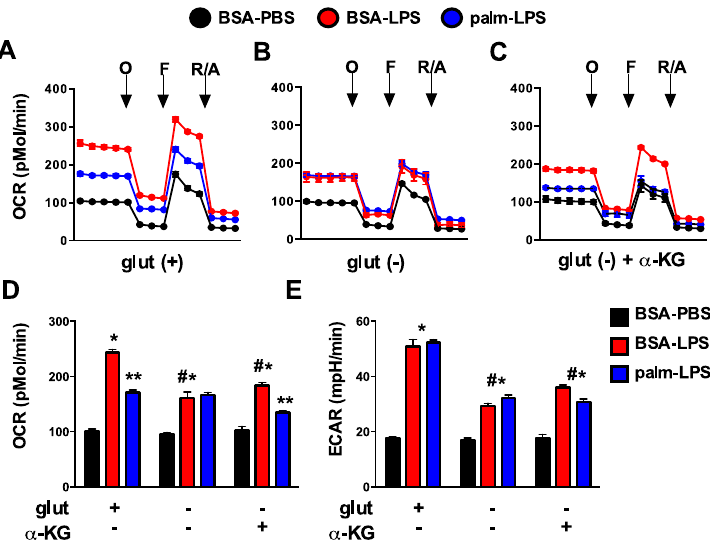
Figure 9. Glutamine deficiency alters mitochondrial metabolism. ( A – C ) pMACs were stimulated for 16 h with BSA ‐ PBS (black), BSA ‐ LPS (red), or palm ‐ LPS (blue) in glutamine sufficient media ( A ) or glutamine deficient media ± α‐ KG ( B , C ) and mitochondrial metabolism was assessed using a Seahorse flux analyzer. Mitochondrial oxygen consumption rate (OCR) was assessed at baseline and after the injection of oligomycin ( O ), FCCF ( F ) and rotenone/antamycin (R/A); ( D , E ) Baesline OCR ( D ) or extracellular acidification rate (ECAR; ( E )) are reported from cells stimulated as in ( A – C ). Bar graphs report the mean ± SE for a minimum of 3 experiments, each performed in triplicate. *, p < 0.05 for BSA ‐ PBS vs . BSA ‐ LPS; **, p < 0.05 BSA ‐ LPS vs . palm ‐ LPS; #, p < 0.05 glutamine vs . no